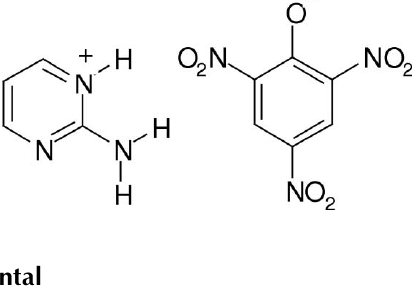
Experimental Crystal data